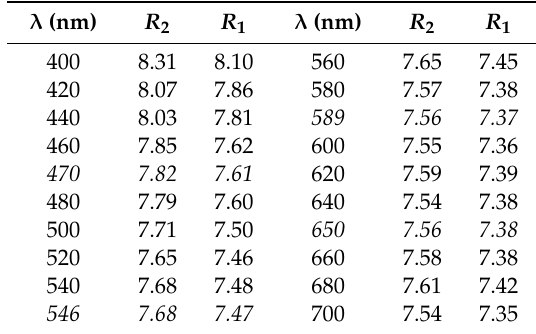
Table 1. Reflectance values (%) measured in air (COM wavelengths in italics). λ